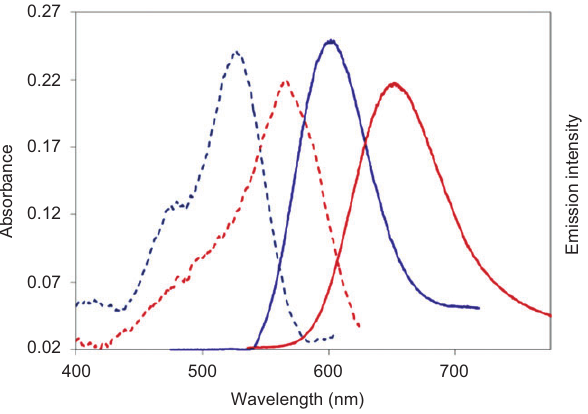
Figure 11 Absorption (dashed line) and luminescence (solid line) spectra of [Tc(dmpe) ] 2 + (red) in aqueous solution compared with 3 [Re(dmpe) ] 2 + (blue) in aqueous solution. Adapted with permission 3 from “ Del Negro, A.S.; Seliskar, C.J.; Heineman, W.R.; Hightower, S.E.; Bryan, S.A.; Sullivan, B.P. J. Am. Chem. Soc. 2006 , 128 , 16494. ”